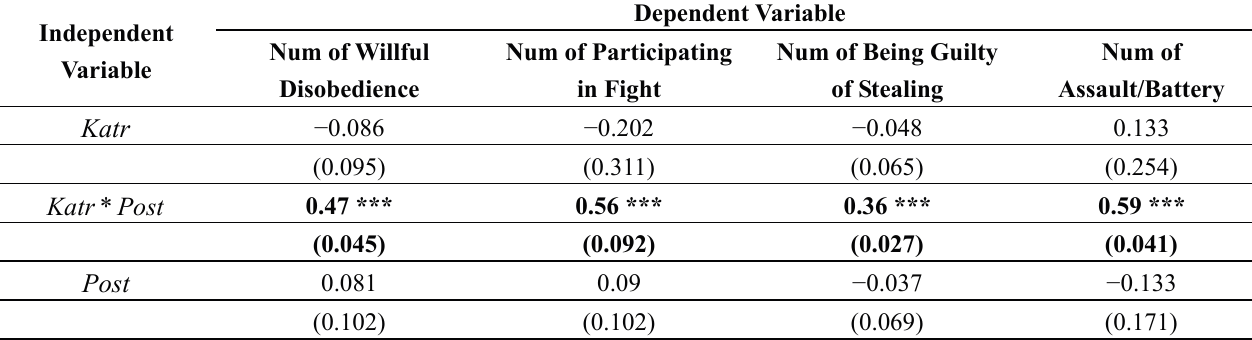
Table A1. Effect of Hurricane Katrina on displaced students’ expected number (in logs) of infraction (N =